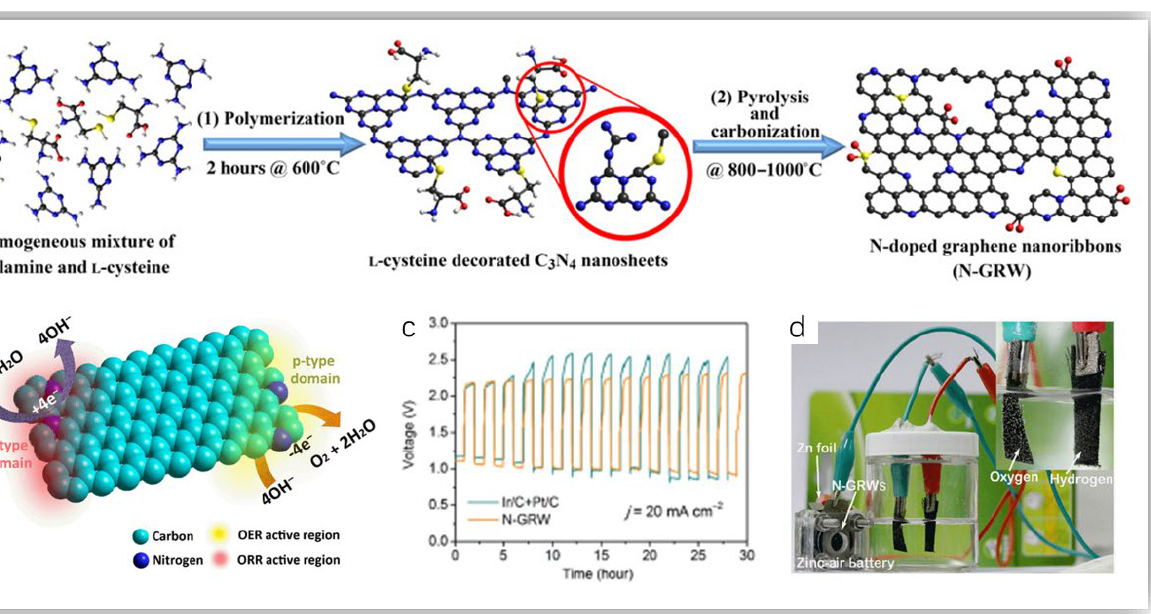
Figure 8. ( a ) Schematic illustration of the synthesis of N-GRW, ( b ) Diagram of ORR and OER mechanism at different active sites on N-GRW catalysts, ( c ) Charging/discharging cycling at current Figure 8. (a) Schematic illustration of the synthesis of N-GRW, (b) Diagram of ORR and OER mech- density of 20 mA · cm − 2 , ( d ) Digital photo of Zn–air battery [91]. Reprinted with permission from anism at different active sites on N-GRW catalysts, (c) Charging/discharging cycling at current den- Ref. [91]. Copyright © 2016, The sity of 20 mA · cm −2 , (d) Digital photo of Zn–air battery [91]. Reprinted with permission from Ref. [91]. Copyright © 2016, The Authors.